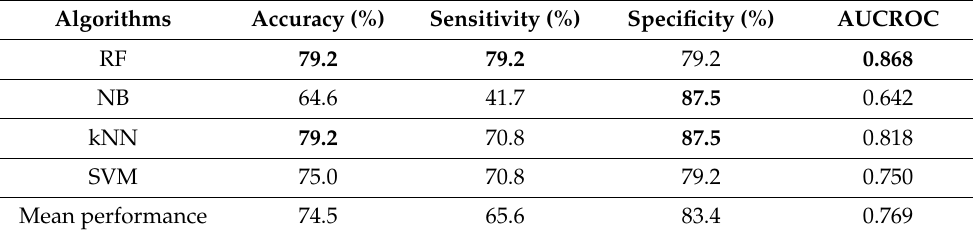
Table 5. Results using US imaging features after the SMOTE technique in predicting long-term medical outcomes.